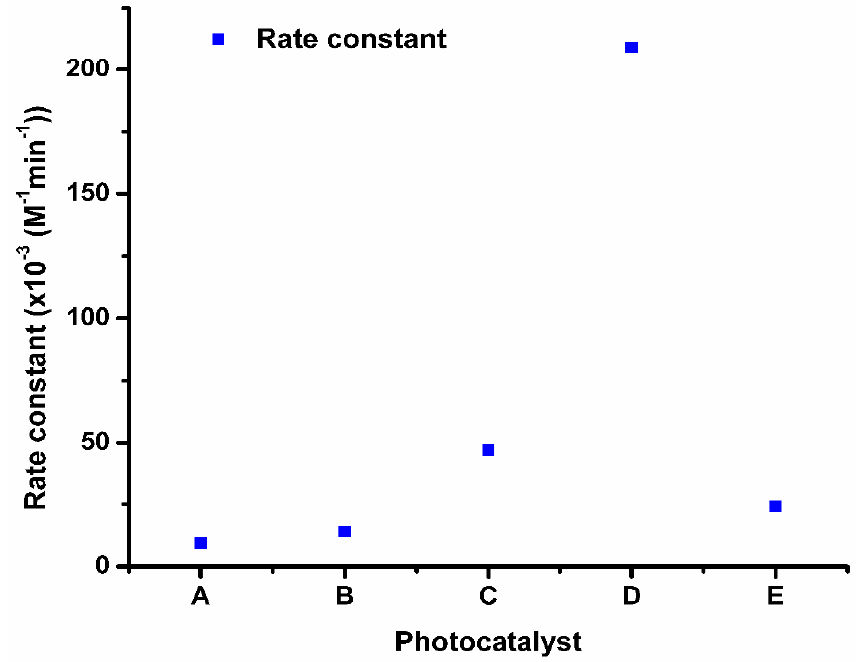
Figure 11. Rate constants of ( A ) WO 3 , ( B ) Mn-WO 3 , ( C ) WO 3 /SnS 2 , ( D ) Mn-WO 3 /SnS 2 and ( E ) SnS 2 . The rate constants were 9.3 × 10 −3 M −1 min −1 , 14.3 × 10 −3 M −1 min −1 , 25.0 × 10 −3 M −1 min −1 , 47.4 × 10 −3 M −1 min −1 and 209.5 × 10 −3 M −1 min −1 , corresponding to WO 3 , Mn-WO 3 , SnS 2 , WO 3 /SnS 2 and Mn- WO 3 /SnS 2 , respectively (Figure 11).